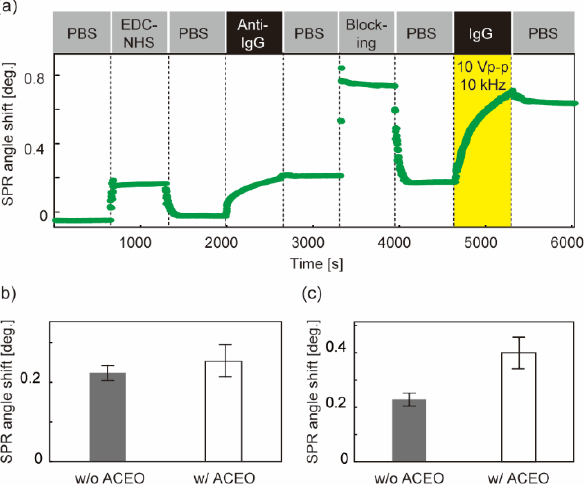
Figure 5. Detection of IgG molecules with ACEO-assisted SPR sensing: ( a ) SPR sensorgram. The style of the figure is the same as in Figure 4a; ( b ) SPR angle shift derived from the number of immobilized antibodies; ( c ) SPR angle shift derived from the analyte bindings. N = 4. Error bars show the standard deviation. Voltage was applied during analyte detection.